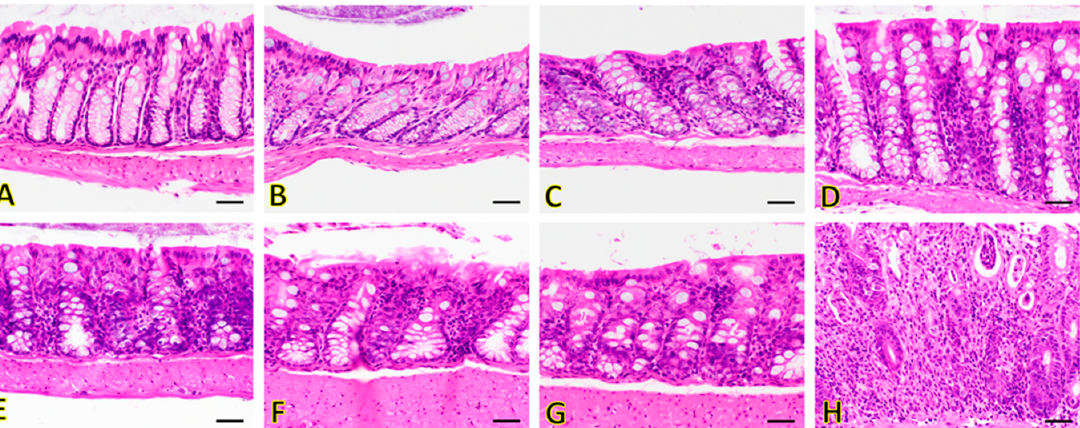
Figure 5. Hematoxylin and eosin (H&E) stained sections of colon in representative IL-2R α -/- mice and wild-type mice. Wild-type ( A , B ) mice show no evidence of inflammation in the colon. Inflammation in the colon increases over time in IL-2R α -/- mice. At 14 weeks (when all the IL-2R α -/- mice had developed colitis), the colon of IL-2R α -/- animals shows minimal inflammatory cell infil- tration expanding the lamina propria ( C ). Inflammatory cell infiltrate generally increases over time in IL-2R α -/- animals from 18 weeks ( D ), 23 weeks ( E ), 26 weeks ( F ), to 30 weeks ( G , H ). Edema, fi- brosis, and ulceration were not observed, and neutrophilic inflammation was only observed at 30 weeks ( G , H ). Magnification: 40×. Scale bar: 20 μ m.